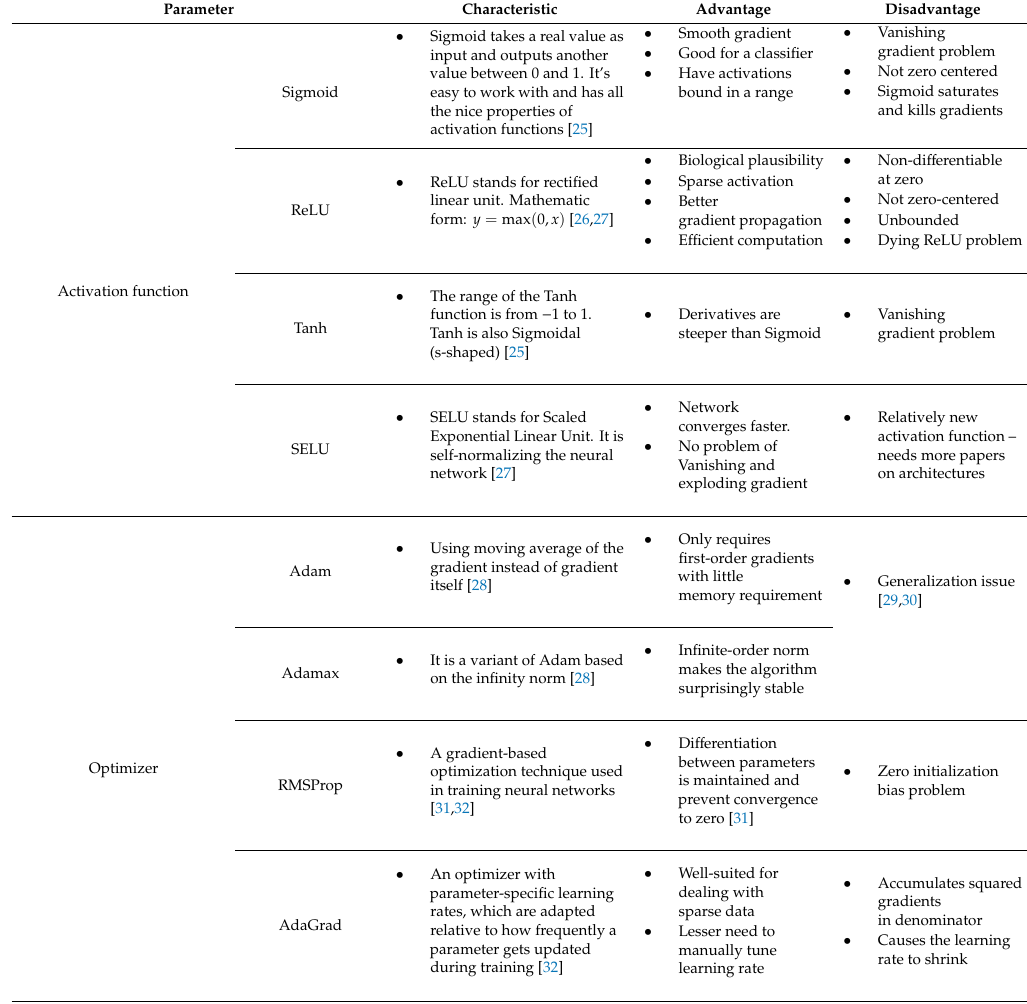
Table 4. Characteristics of activation functions and